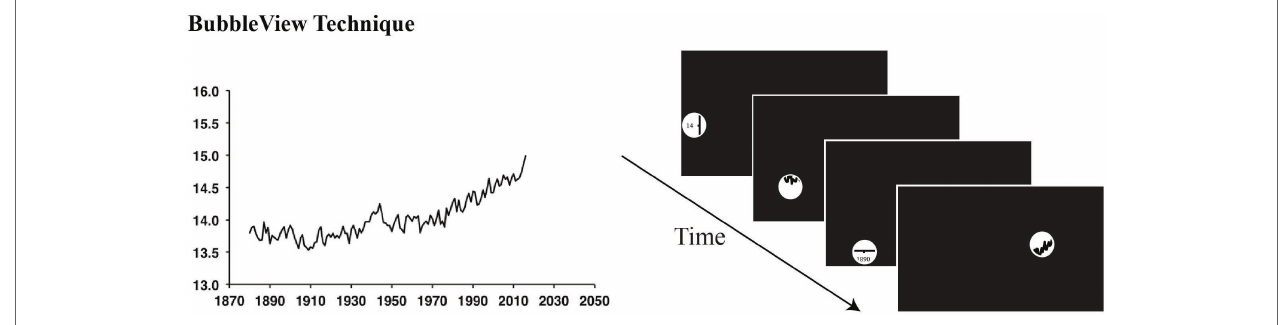
FIGURE 4 | Experiment 2 Methods. Using the BubbleView technique, the graph on the left was covered by a black mask, and only a small circular area around the mouse was transparent. Participants had to move their mouse to see the